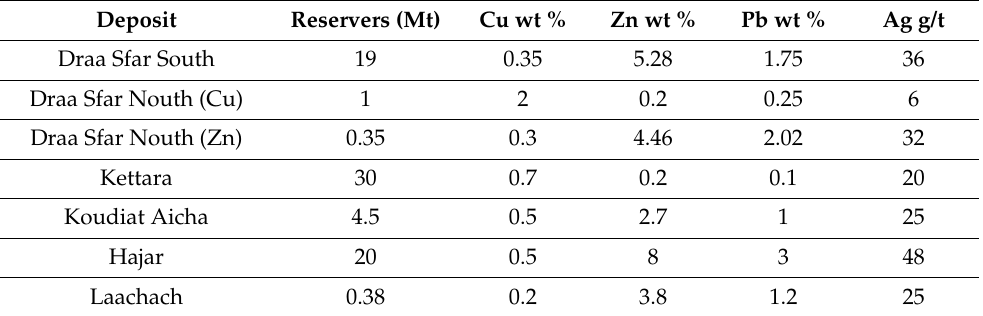
Table 1. Ore reserves and average grade of selected deposits in the Jebilet-Guemassa district. Deposit Reservers